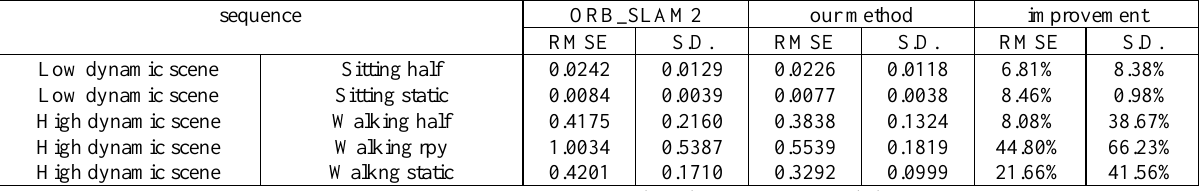
Table 1. Absolute trajectory error (ATE) of TUM dataset (m)